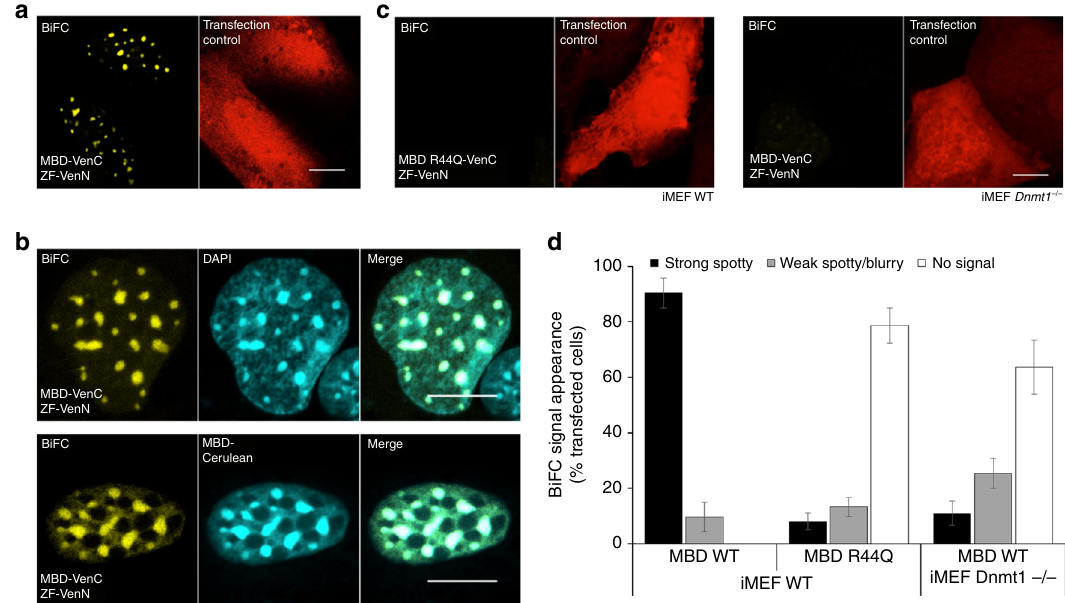
Fig. 2 Development and validation of the BiAD sensor 1. a Representative fl uorescence microscopy image of the BiFC signal ( yellow channel ) generated upon transfection of the BiAD sensor 1 in iMEF cells. A plasmid encoding NLS-mRuby2 was used to identify transfected cells ( red channel ). b Representative fl uorescence microscopy images documenting co-localization of the BiFC signal with DAPI stained major satellite DNA ( upper panel ) and 5mC marks detected by co-transfection of the sensor modules with MBD-Cerulean ( lower panel ). c Representative fl uorescence microscopy images documenting the 5mC speci fi city of the BiAD sensor. The BiFC signal was lost with the MBD R44Q 5mC-binding pocket mutant ( left ) and in cells with globally reduced DNA methylation levels ( right ). A plasmid encoding NLS-mRuby2 was used to identify transfected cells ( red channel ). The transfection, imaging and display settings of the images shown in panels a , c are identical. d Quanti fi cation of the experiments representatively shown in panels a – c . The error bars represent the s.e.m. for two biological repeats (for details cf . Methods and Supplementary Tables 1, 6, and 7). All cells were fi xed at 48 h after transfection. Scale bar for all images is 10 µ